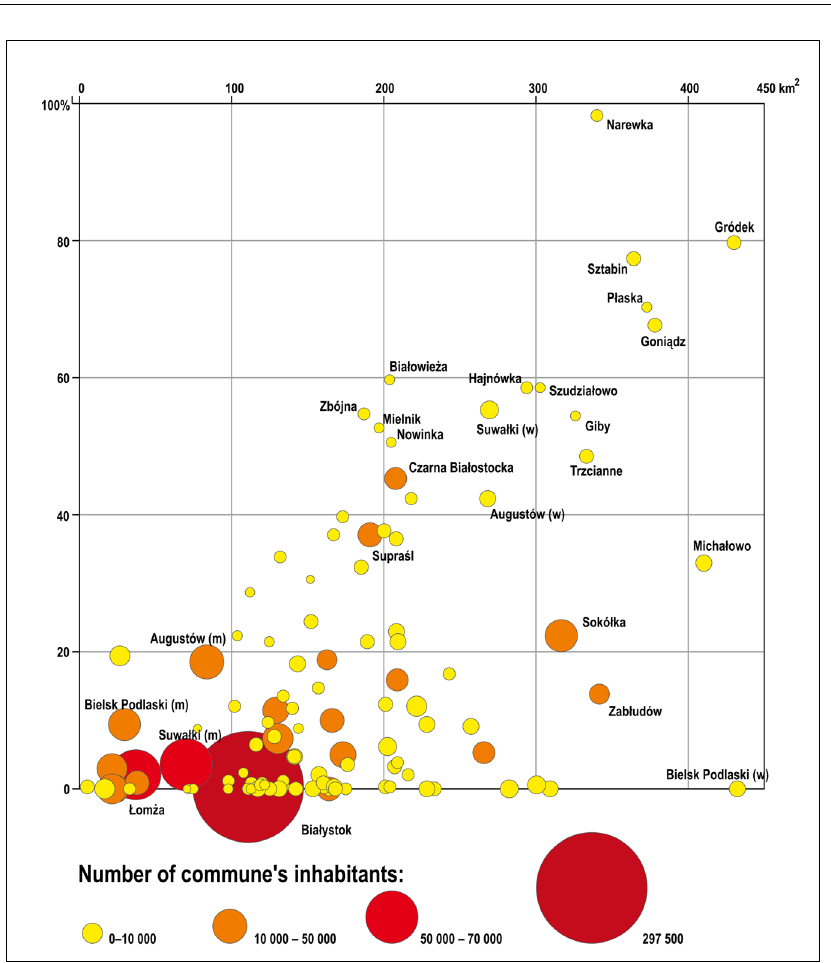
Fig. 9. The graph of legally protected area, commune’s area and communes